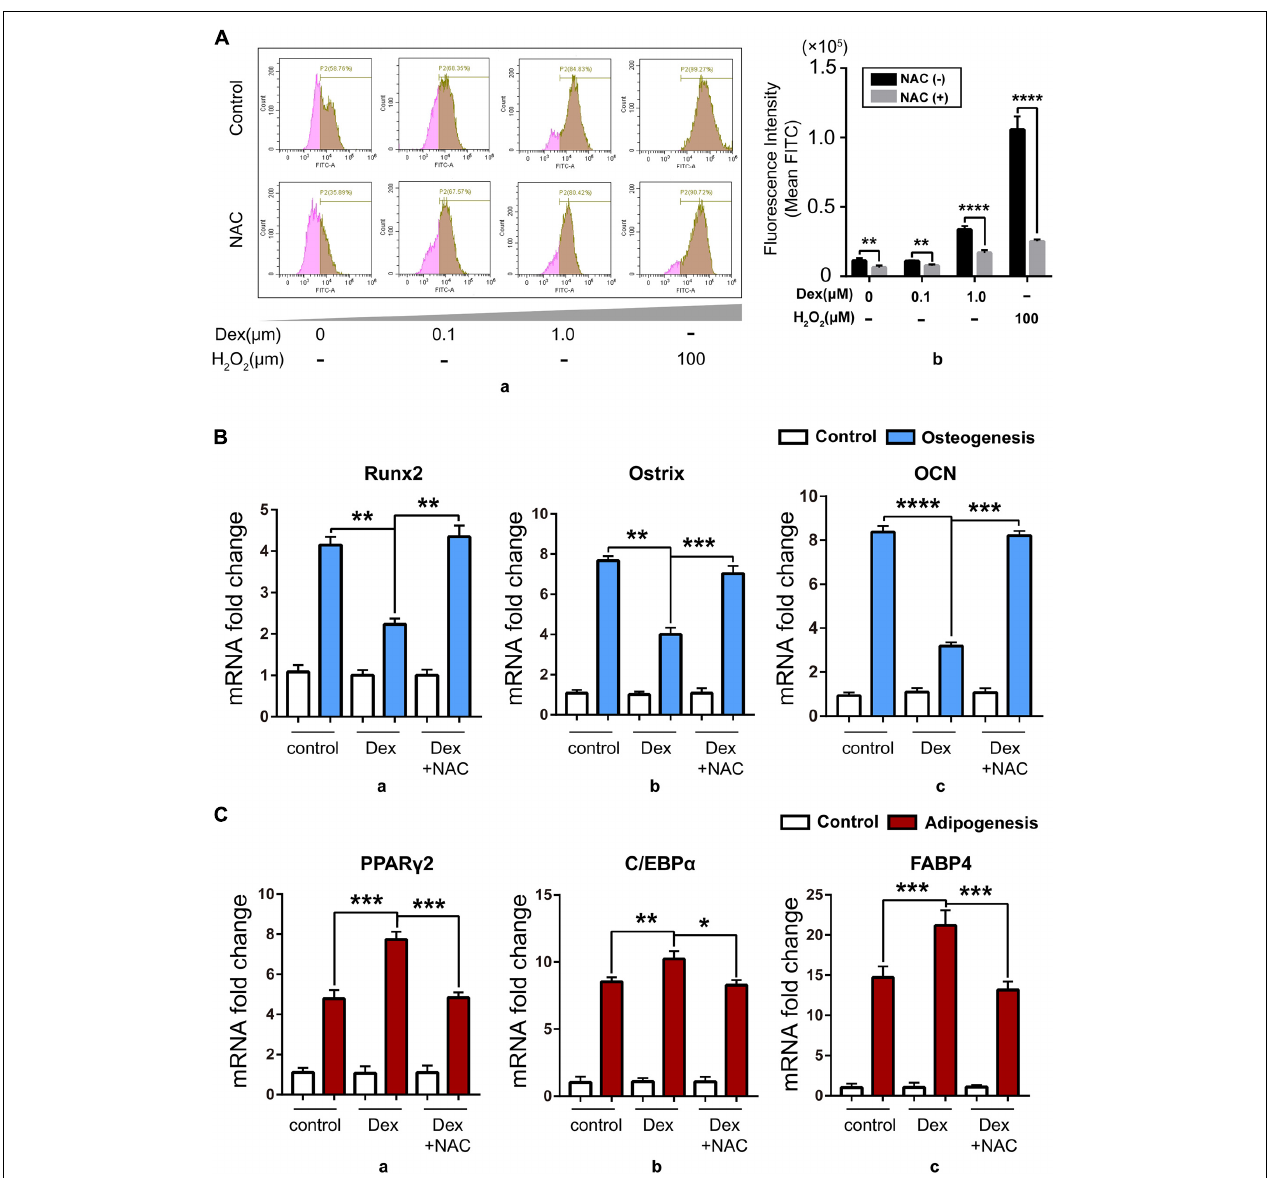
FIGURE 2 | Dex damaged osteogenesis while compensating for enhanced adipogenesis in vitro by upregulating cellular ROS level. (A) The cellular ROS level in BM-MSCs with 0, 0.1, and 1.0 µ M Dex treatment for 24 h detected by flow cytometry after DCFH-DA staining (100 µ M, 15 min) with/without 5 mM NAC treatment, and 100 µ M H 2 O 2 treatment for 30 min was used as positive control. Data were shown in peak map (a) and histogram (b) ; (B) The expression of osteogenic marker genes including Runx2 (a) , Ostrix (b) , OCN (c) in BM-MSCs of control group and Dex-treated group with/without NAC after 7-day osteogenic induction was detected by Q-PCR; (C) The expression of adipogenic marker genes including PPAR γ 2 (a) , C/EBP α (b) , fatty acid binding protein 4 (FABP4, c ) in BM-MSCs of control group and Dex-treated group with/without NAC after 7-day adipogenic induction was detected by Q-PCR; Data are shown as the mean ± SEM. * p < 0.05, ** p < 0.01, *** p < 0.005, **** p < 0.001. All the data were obtained from at least three independent